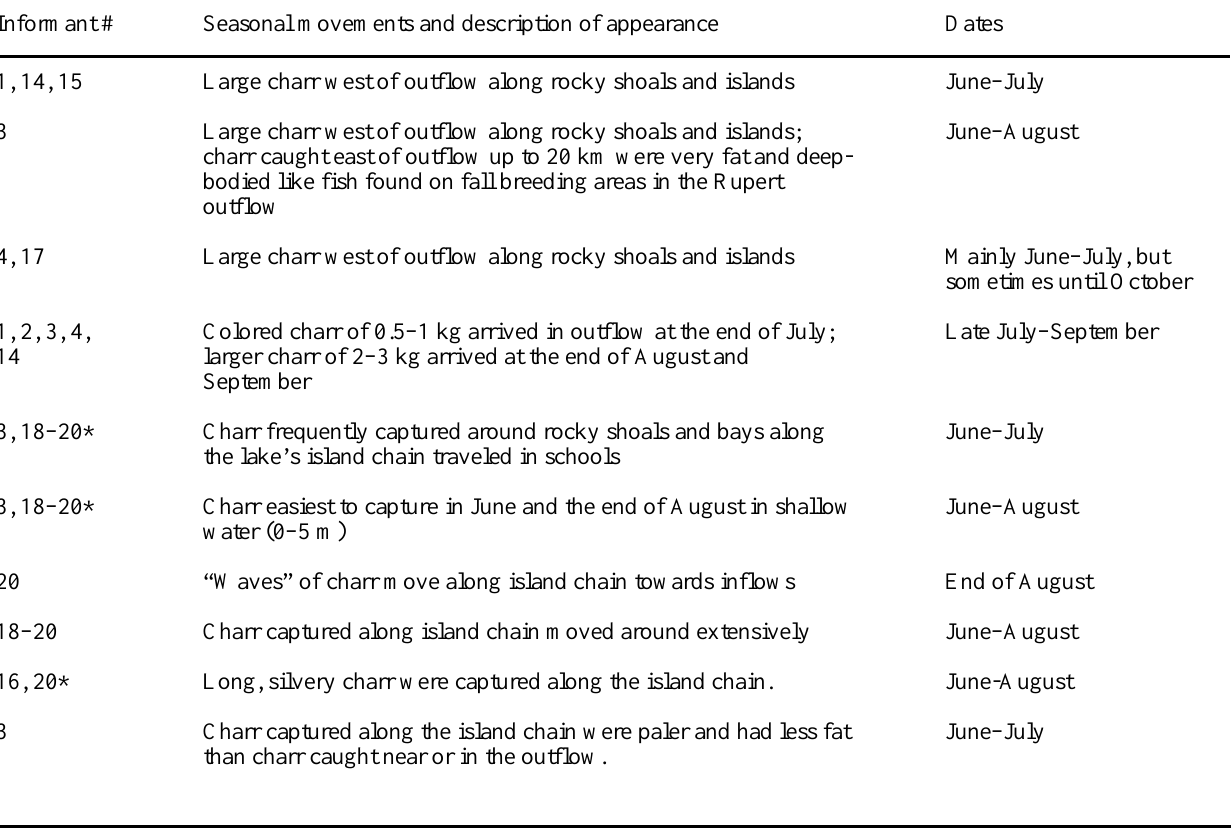
Table 4. Summary of traditional ecological knowledge (TEK) for brook charr feeding area characteristics reported by local experts of the community of Mistissini. When information was unavailable from particular experts, blank spaces are used. Asterisks denote when community fishers and/or fishing guides made similar